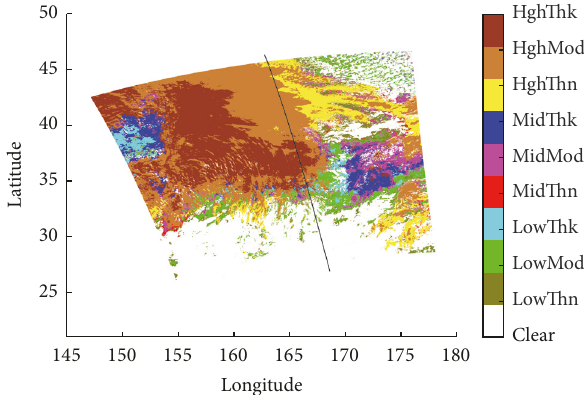
Figure 2: ISCCP cloud-type classification derived from MODIS data with CloudSat ground track overlaid for an example case collected at 02:15 UTC on 10 March